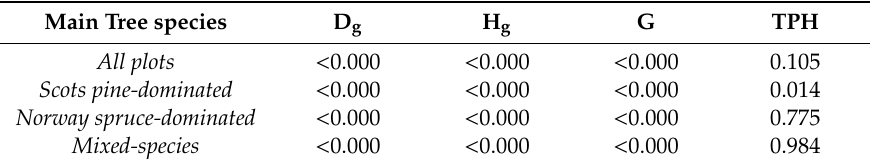
Table 7. The p-values from the paired-sample t-tests indicating the significance of the di ff erences between the TLS-derived estimates on forest structural attributes, such as basal area-weighted mean diameter (D g ) and - height (H g ), mean basal area (G) and trees per hectare (TPH) by main tree species measured in 2014 (T1) and 2019 (T2). Main Tree species D